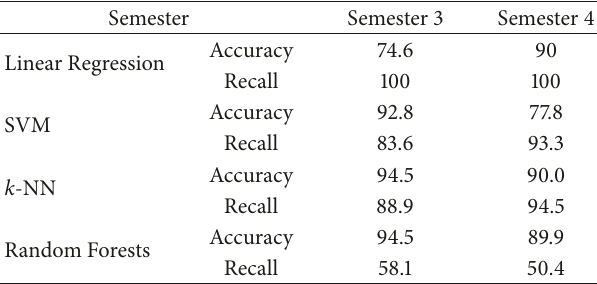
Table 2: Link prediction results for the cognitive network. Table 3: Link dissolution prediction results for the behavioral and cognitive networks using Linear